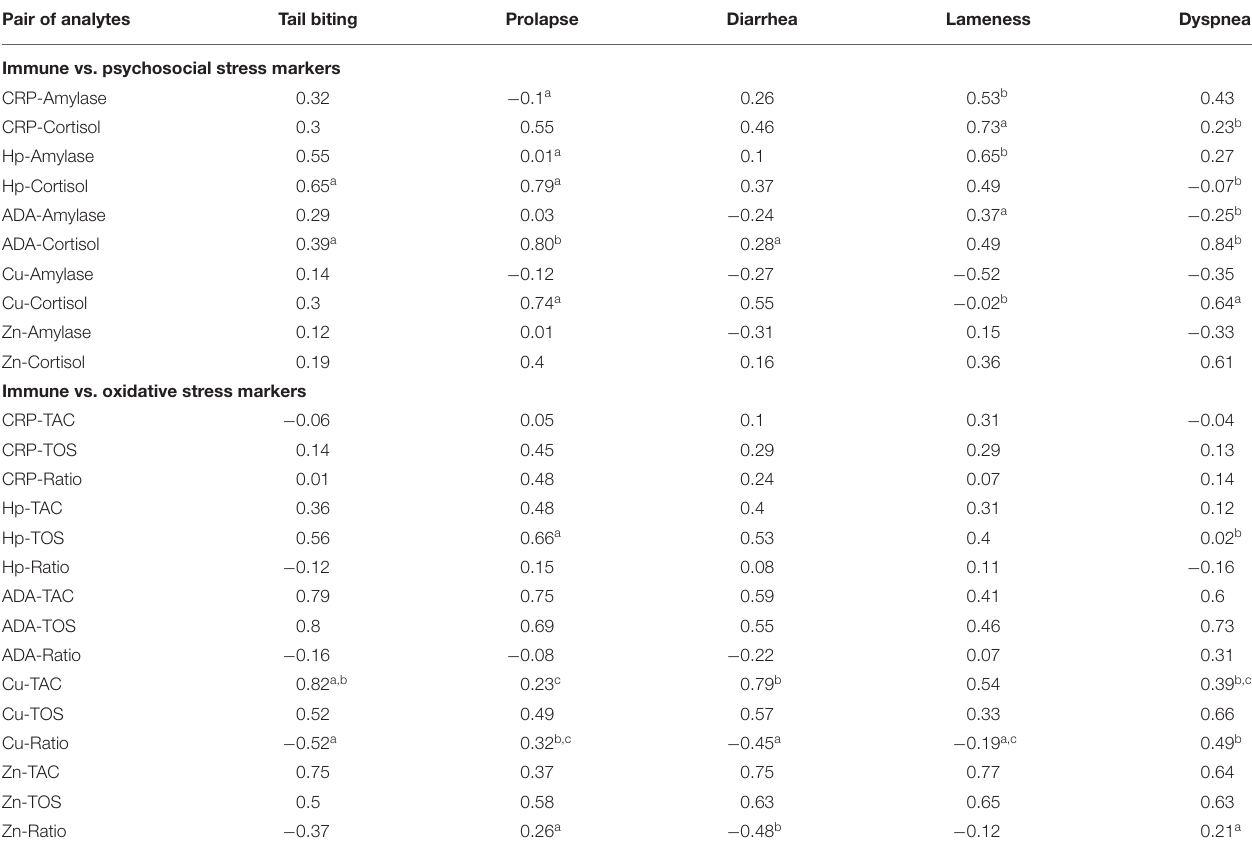
TABLE 2 | Spearman’s correlation coefficients between immune and stress biomarkers in animals suffering from a pathological condition (tail-biting lesions n = 13, rectal prolapse n = 13, diarrhea n = 13, lameness n = 14, or dyspnea n = 14) including a healthy group of animals ( n = 10) from the same farm. Pair of analytes Tail biting Prolapse Diarrhea Lameness Dyspnea Immune vs. psychosocial stress